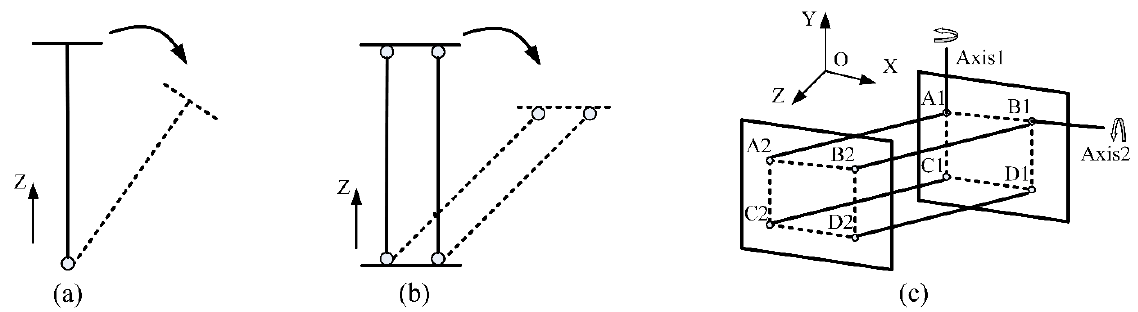
Figure 3. Double parallel linkage. ( a ) Single linking bar; ( b ) Two parallel linking bars; ( c ) Double parallel linkage.